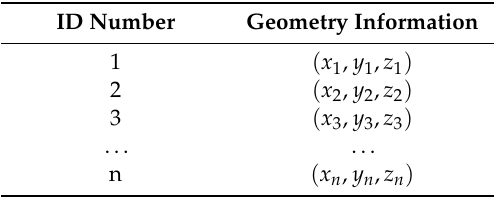
Table 2. The node structure in the network data